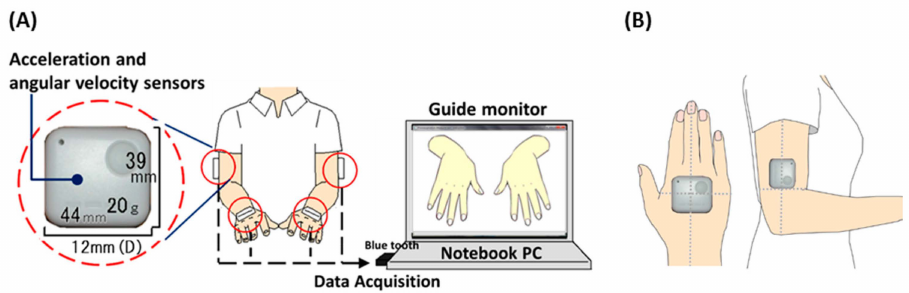
Figure 1. System configuration ( A ) and the position of sensors ( B